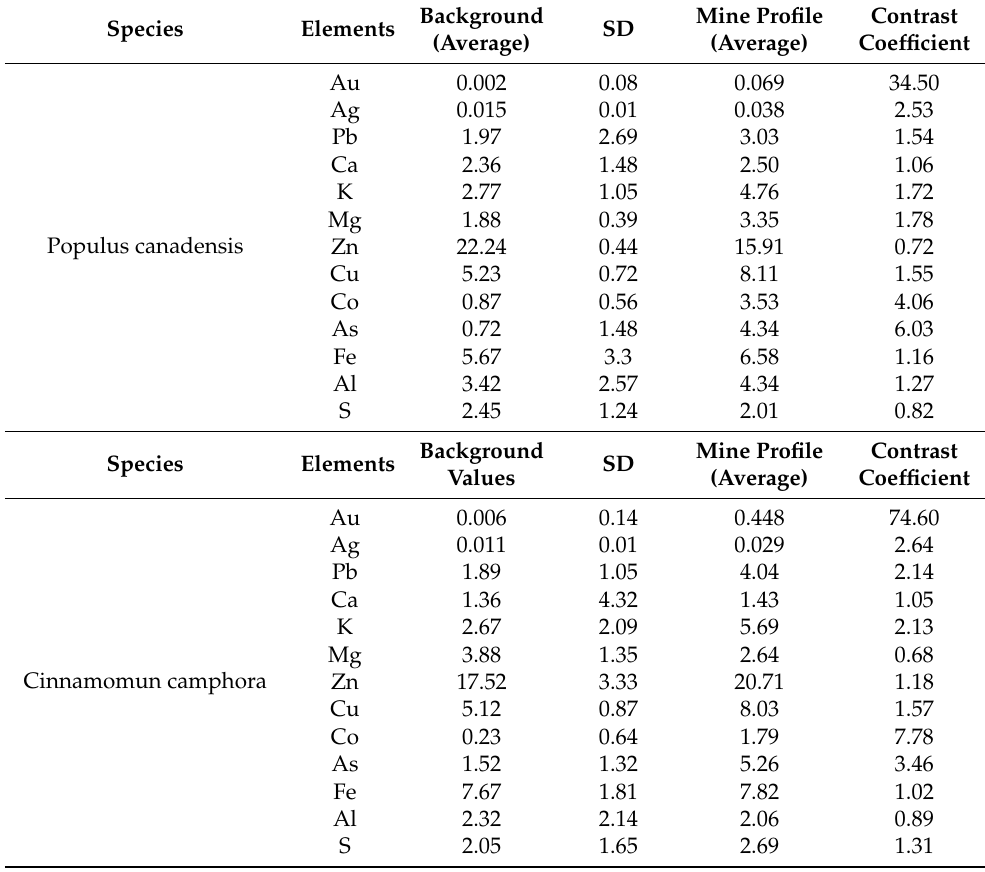
Table 4. Elements content and contrast coefficient of dominant plants (mg/kg).